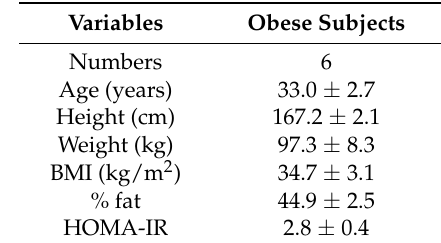
Table 1. Subject